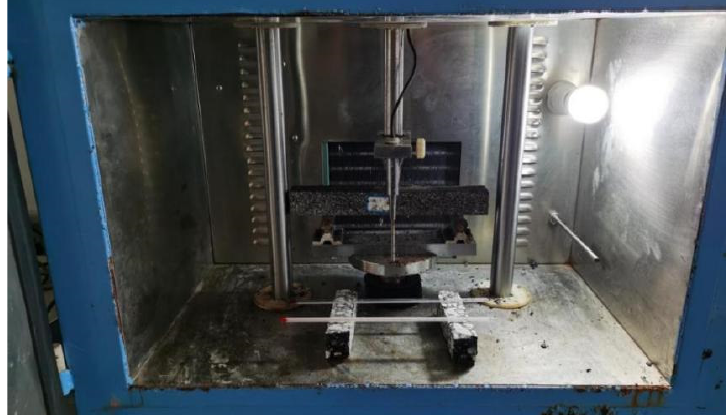
Figure 3. Test setup for low temperature bending beam creep.